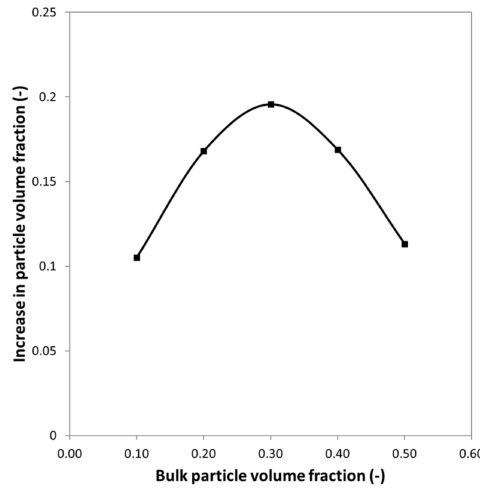
Figure 8. Increase in particle volume fraction at the center versus the bulk particle volume fraction for fully developed profiles for case 4 given in Table 4.